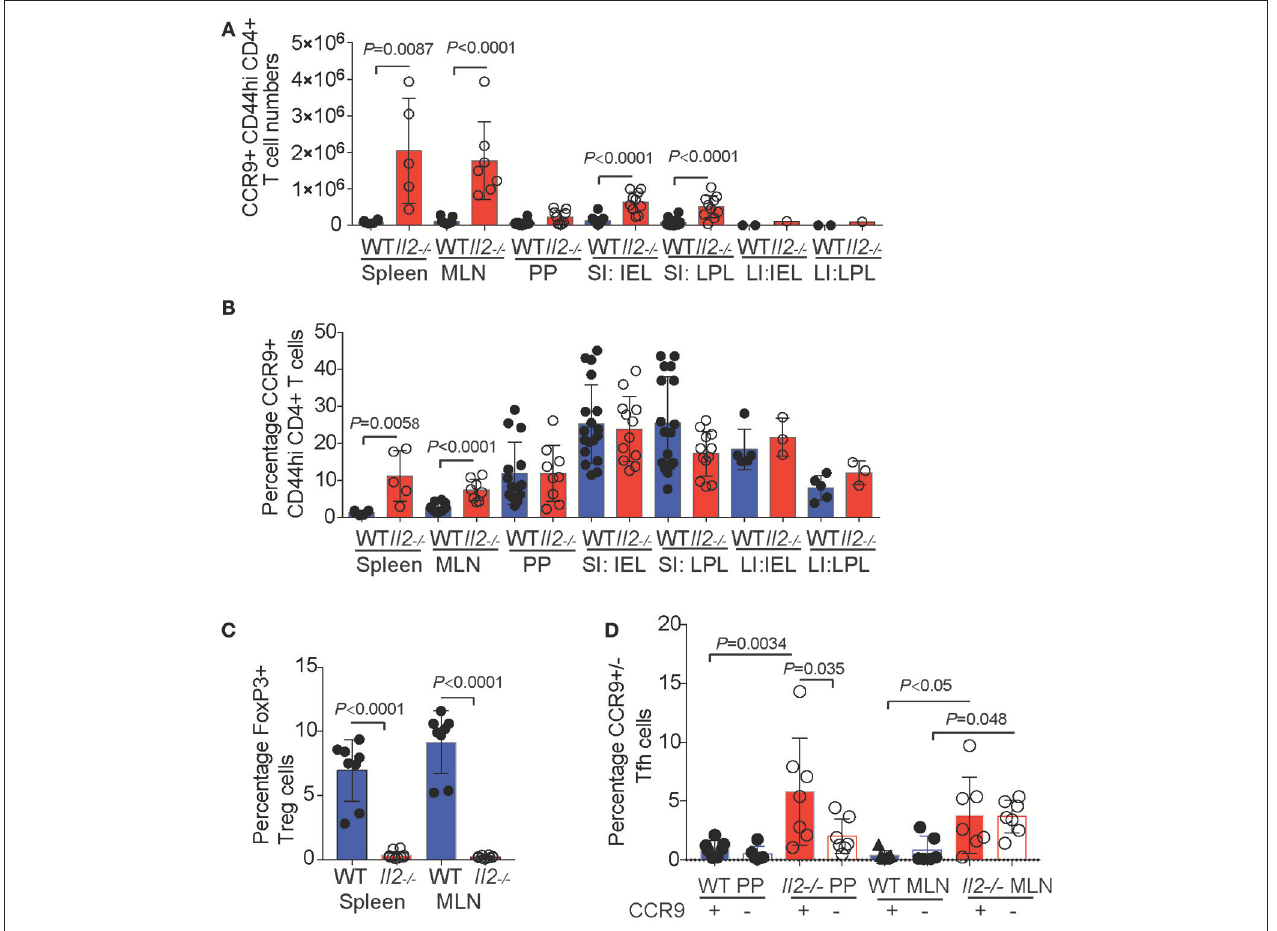
FIGURE 2 | Expansion of CCR9 + CD4 + T cells in Il2 − / − mice. Numeration (A) and percentages (B) of CCR9 + and CCR9 − CD44 hi CD4 + T cells in Il2 − / − and WT mice determined by FACS analysis. (MLN) mesenteric lymph nodes; (PP) Peyer’s Patches; (SI IEL) intraepithelial lymphocytes of the small intestine; (SI LPL) lamina propria lymphocytes of the small intestine; (LI IEL) intraepithelial lymphocytes of the large intestine; (LI LPL) lamina propria lymphocytes. (C) Percentages of FoxP3 + CD4 + TCRb + T regulatory (Treg) cells in the spleen and MLN and (D) percentages of CXCR5 + PD1 + FoxP3 − CD4 + TCRb + T follicular helper (Tfh) cells in the PP and MLN of Il2 − / − and WT mice. Data shown as mean ± SD, where n = 3-15 female mice 7-9 weeks of age. Statistical significance was analyzed by students T -test.